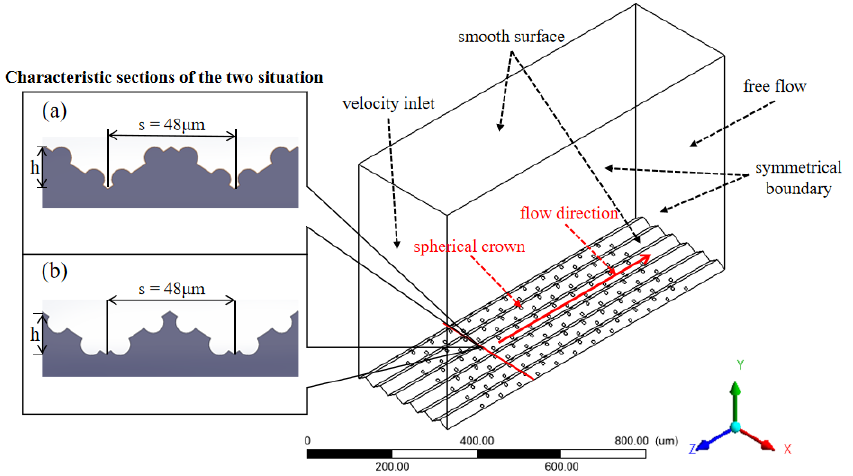
Figure 3. Flow region with two different surfaces; ( a ) positive crowns, ( b ) negative